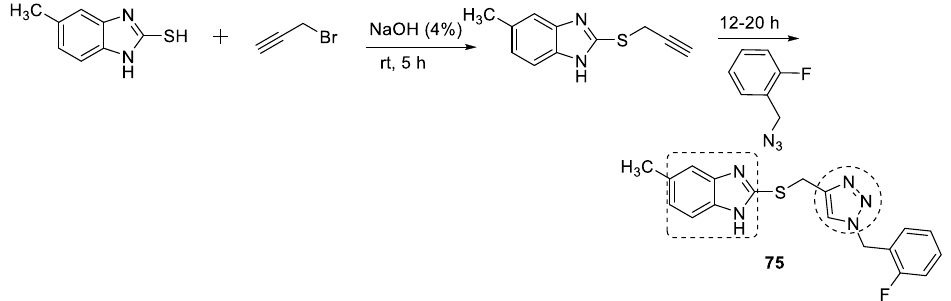
Figure 26. Chemical structure of benzimidazole – 1,2,3-triazole hybrid.